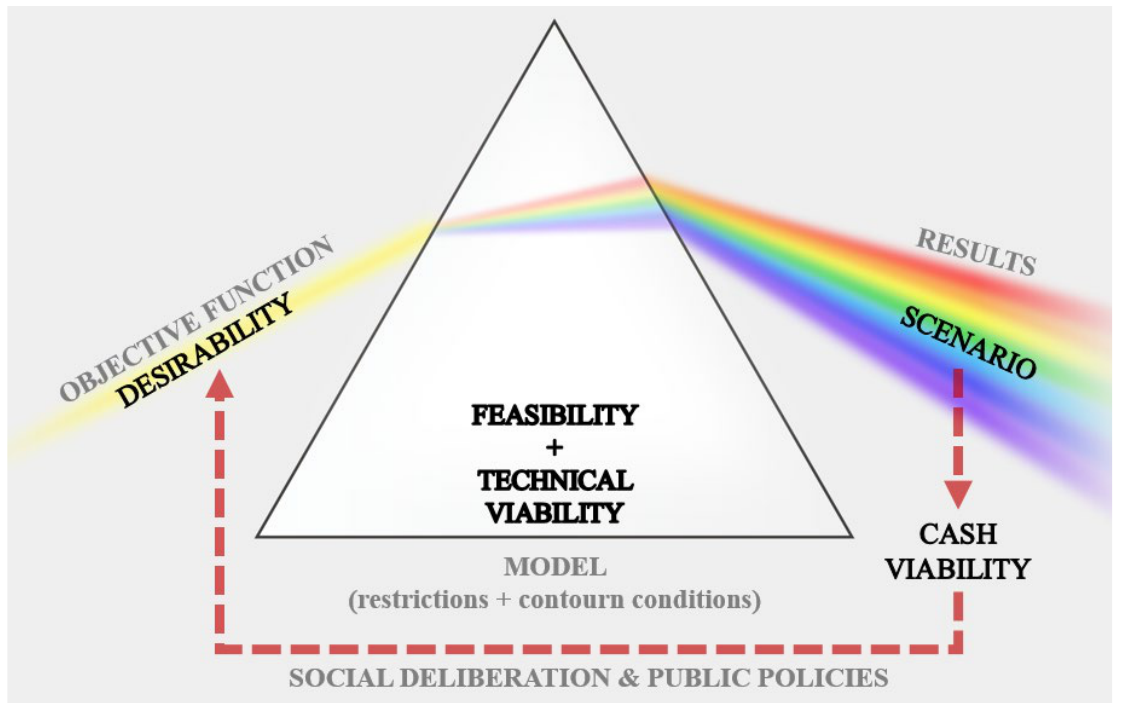
Figure 1. Conceptual scheme for the capabilities considered in SAFRA modeling. Source: Our own, based on [23]. The background drawing on the refraction of light has been taken from the free media repository of Wikipedia Commons (https://commons.wikimedia.org/wiki/Prism).